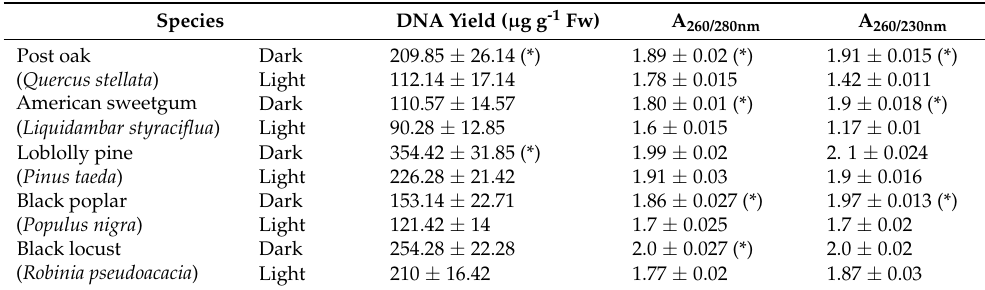
Table 1. Comparison of quantities and quality of DNA extracted from in situ dark- or light-adapted mature post oak ( Q. stellata ), American sweetgum ( Liquidambar styraciflua ), loblolly pine ( Pinus taeda ), black poplar ( Populus nigra ) and black locust ( Robinia pseudoacacia ) leaves using the extraction method M1. DNA yield is expressed as µ g g − 1 fresh (leaf) weight (Fw). A 260/280nm ratios are indicative of the presence or absence of protein-type contaminants in the DNA extract and A 260/230nm ratios of the presence or absence of carbohydrate or phenolic contaminants. Data are shown as means ± standard error (SE) of 3 extractions ( n = 3) per species. Quantitative and qualitative differences between DNA extracted from dark- and light-adapted leaves were analyzed using a paired t -test, at a significance level of p < 0.01. Significant differences between dark/light treatments are denoted by the (*) asterisk for each